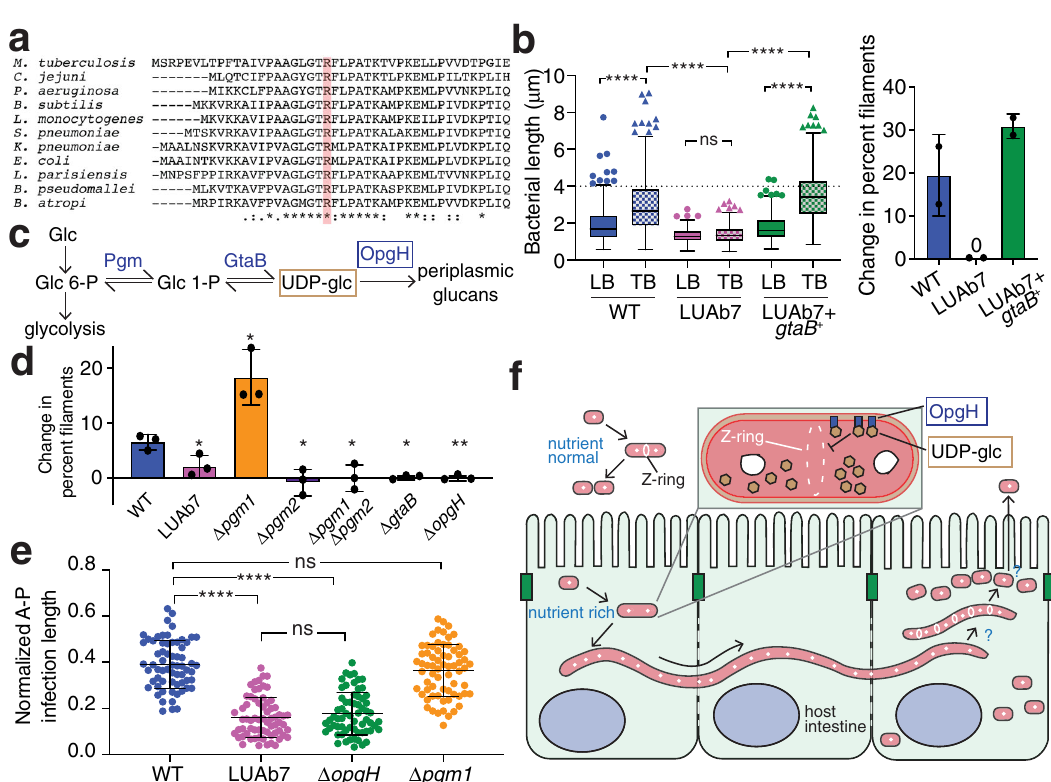
Fig. 5 The UDP-glucose biosynthetic pathway is required for fi lamentation. a CLUSTAL O multiple sequence alignment of GtaB from divergent bacteria with the predicted catalytic arginine highlighted. b In vitro fi lamentation of LUAb7( gtaB R17C ) and the complemented LUAb7 + gtaB + as measured by bacterial length in LB and TB ( n = 150, 2 independent experiments, Tukey ’ s plot with boxes ’ lower and upper bounds representing 25th and 75th percentiles, respectively, center lines representing medians, lower whiskers representing minima and upper whiskers representing largest values less than 75th percentile plus 1.5 times interquartile range (IQR). Individual points are values that are larger than 75th percentile + 1.5 IQR). The cutoff for a fi lament is 4 μ m (hatched line) ( left ), p < 0.0001 (****) or not signi fi cant (ns) by Kruskal-Wallis test followed by Dunn ’ s post test with multiple-comparison correction. The change in percent fi laments was measured (% fi laments in TB − % fi laments in LB) ( right ). Bar graphs are presented with means and SD error bars. Each point represents value from an independent experiment. c The UDP-glucose biosynthetic pathway converting glucose ( glc ) to UDP-glucose ( UDP-glc ). d B. atropi knockouts measured for the change in percent fi laments. Results are from 3 independent experiments, n > 400 bacteria per replicate, p < 0.05(*) or p = 0.0087(**) by unpaired two-tailed t -test with Welch ’ s correction compared to WT. Exact sample sizes for each group are provided in Source Data. Bar graphs show means with SD error bars. e Anterior to posterior (A-P) spr e ading of B. atropi mutants in vivo, normalized to animal length. Results are from n = 65 (WT), 67 (LUAb7), 64 ( Δ opgH ), and 68 ( Δ pgm1 ) animals examined over 2 independent experiments, p < 0.0001 (****) or not signi fi cant (ns) by Mann – Whitney unpaired two-tailed t -test. Error bars represent SD. f Model for B. atropi intracellular fi lamentation and